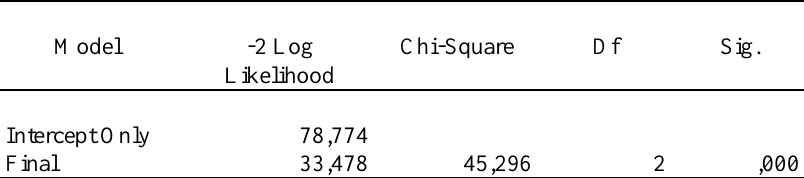
Table 6. G Statistical Test Results